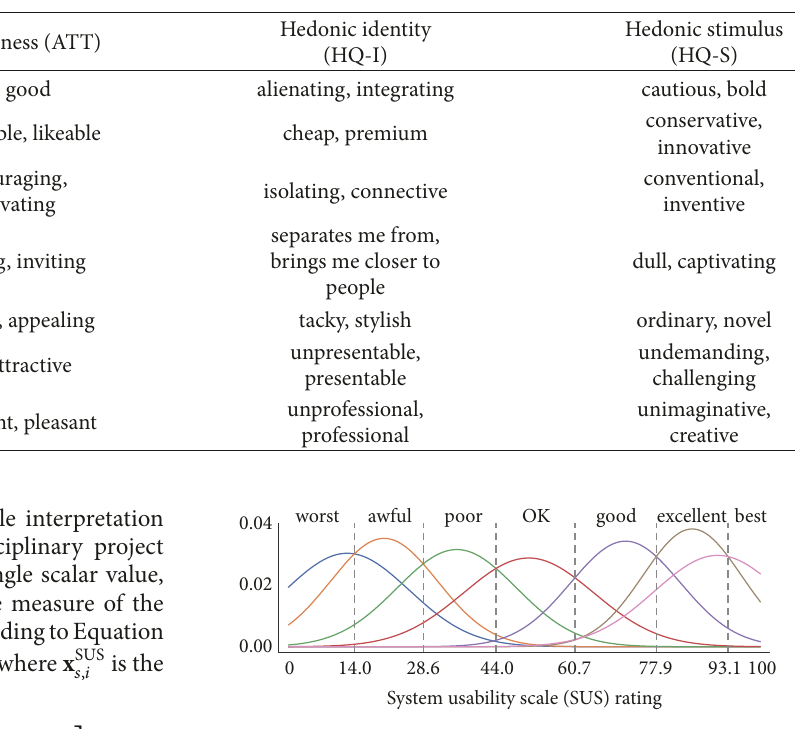
Table 2: AttrakDiff-2 statement pairs. The pairs of complementary adjectives are clustered into four groups, each associated with a different aspect of quality. All 28 pairs are presented to participants in randomized order.